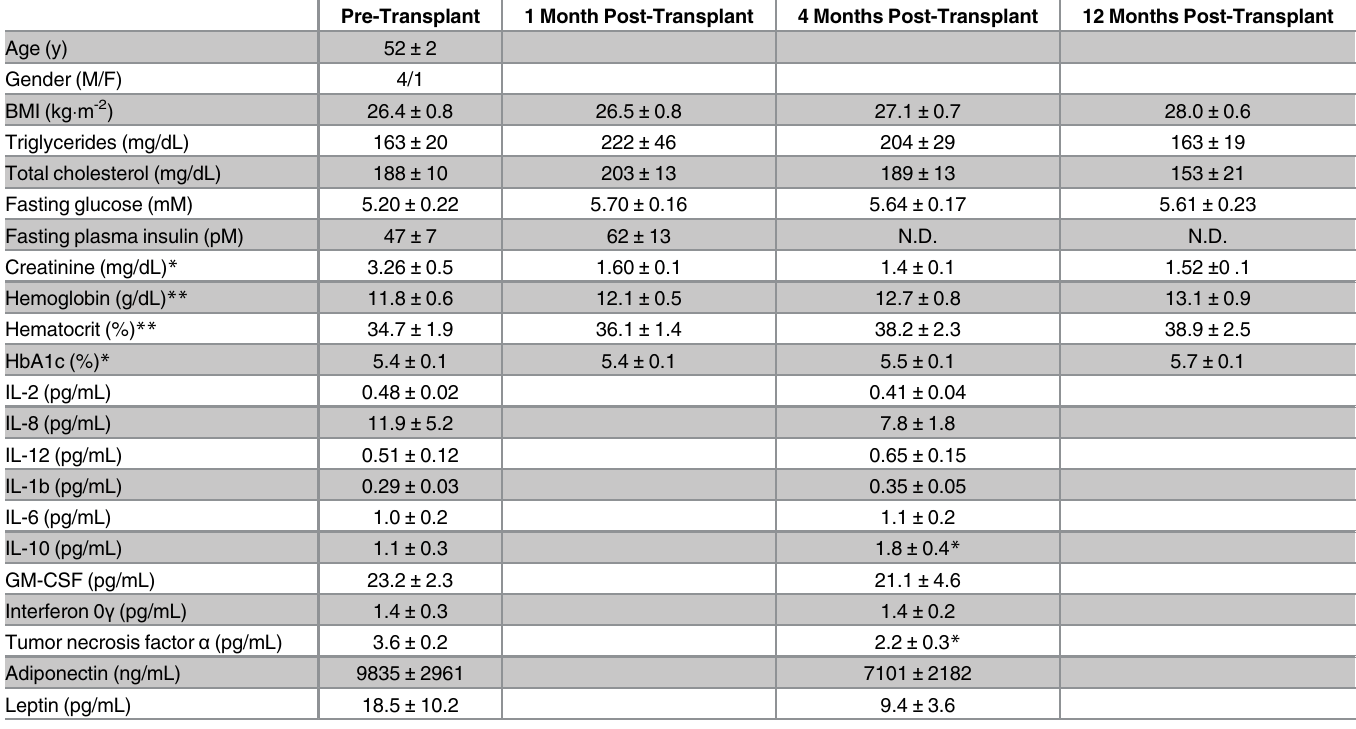
Table 1. Patient characteristics and inflammatory markers pre- and